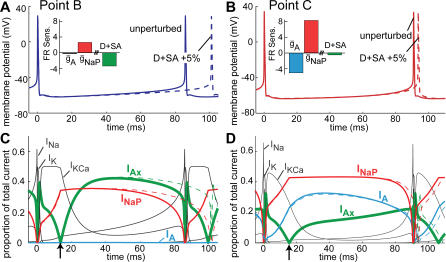
The Relative Size of Intrinsic Currents Determined the Size of Parameter Sensitivities(A) The unperturbed somatic voltage trace of the model labeled “B” in Figures 3A and 4D (solid line), compared with the voltage trace after a 5% increase in D + SA (dashed line). Inset barplot shows that spontaneous firing rate sensitivity of this model to
was low (blue), but high to
(red) and D + SA (green).
(B) Somatic voltage traces of the model labeled “C” in Figures 3A and 4D. Labeling scheme is analogous to that in (A): the unperturbed model (solid) is compared with a 5% D + SA increase (dashed). Here, firing rate sensitivity was high to
and
but low to D + SA.
(C–D) The absolute value of each intrinsic current, normalized by the absolute sum of somatic membrane and axial currents at each time step, for the models shown in (A) and (B), respectively. The Na, K, and K–Ca currents are shown in gray (INa, IK, IK-Ca). Also shown are A-current and NaP current (IA, determined by
, in solid blue; INaP determined by
in solid red) and the somato-dendritic axial current (IAx, determined by morphologic parameters, in heavy solid green). Black arrows indicate artifactual inflection points creased by taking the absolute value, when the unnormalized current reversed sign. For both points B and C, increasing D + SA delayed the next AP and reduced firing rate by increasing IAx; IA and INaP were also perturbed through their interactions with IAx (dashed colored lines).
(C) At point B, IAx dominated during the ISI, so that the D + SA perturbation had a large effect on IAx, and INaP. As a result firing rate sensitivity to D + SA was high.(D) At point C, IAx was relatively small throughout most of the ISI. Hence, increasing D + SA had a small effect on the intrinsic currents overall, so that firing rate sensitivity to D + SA was low.